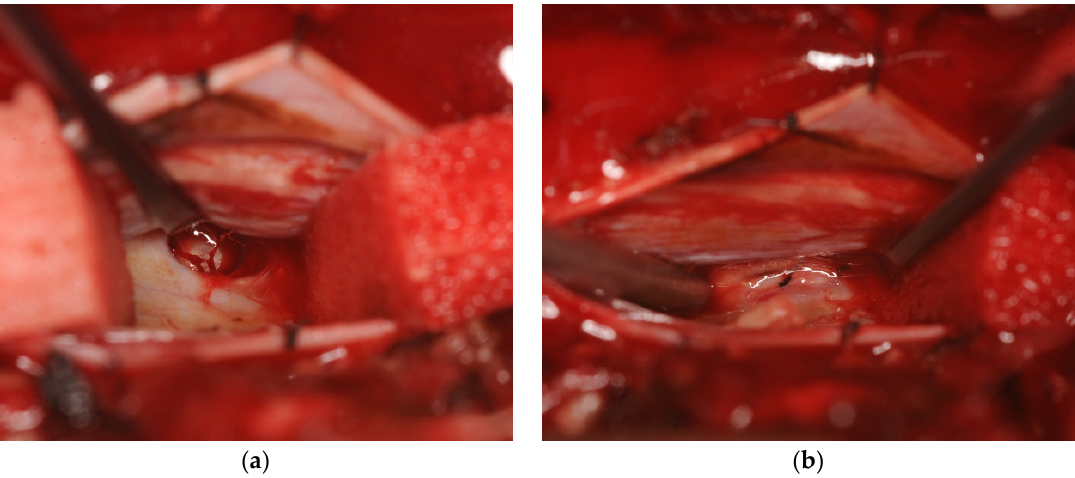
Figure 4. Intraoperative images of the T5–T6 dural defect before ( a ) and after ( b ) primary suture. In both images, caudal is on the left side of the image and the spinal cord is retracted superiorly.